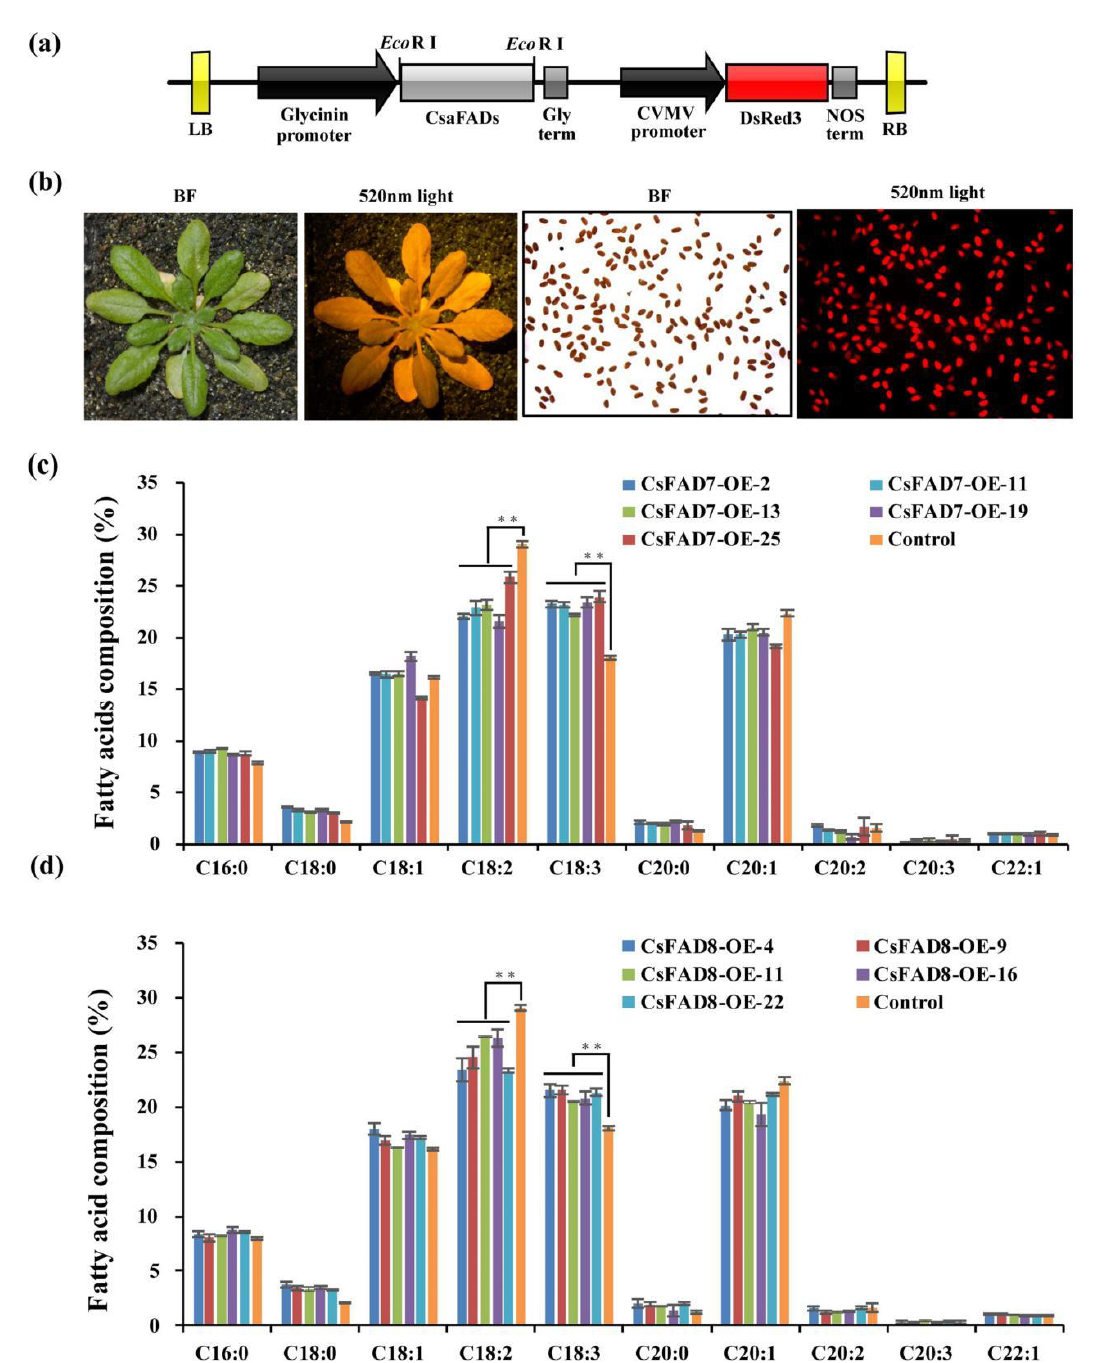
Figure 6. Transgenic screen of CsaFAD7 and CsaFAD8 seed-specific overexpression lines and fatty acid composition. ( a ) CsaFADs overexpression cassettes structure. LB, left border; RB, right border; Gly term, Glycinin terminator; NOS term, nopaline synthase terminator. ( b ) Screening of transgenic lines according to red fluorescence DsRed3 marker. BF, bright field; 520 nm light, seedlings and seeds were activated by wavelength 520 nm light. ( c , d ) Fatty acid composition in CsaFAD7 and CsaFAD8 overexpression lines. T3 generation dry mature seeds were collected for GC analysis with 5 times repeat for each line. Asterisk represents a significant difference ( p < 0.01, n = 5).